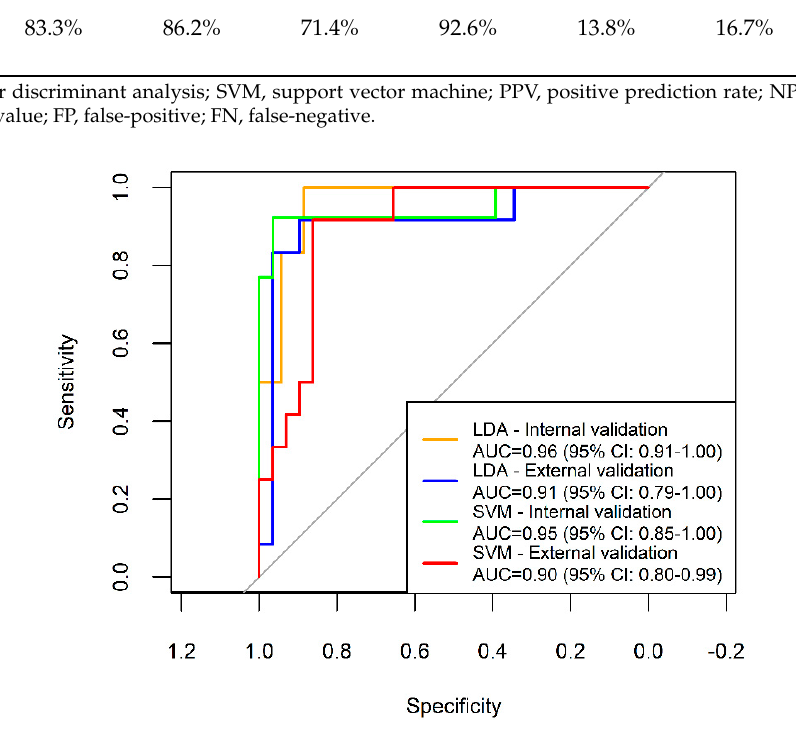
Table 2. Diagnostic accuracy of the E-nose.